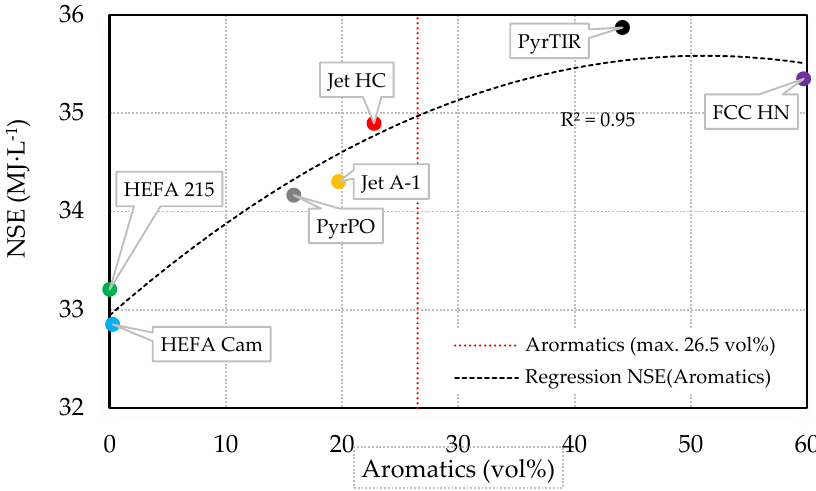
Figure 11. Relationship between measured net specific energy (MJ·L − 1 ) and aromatics of the samples studied.